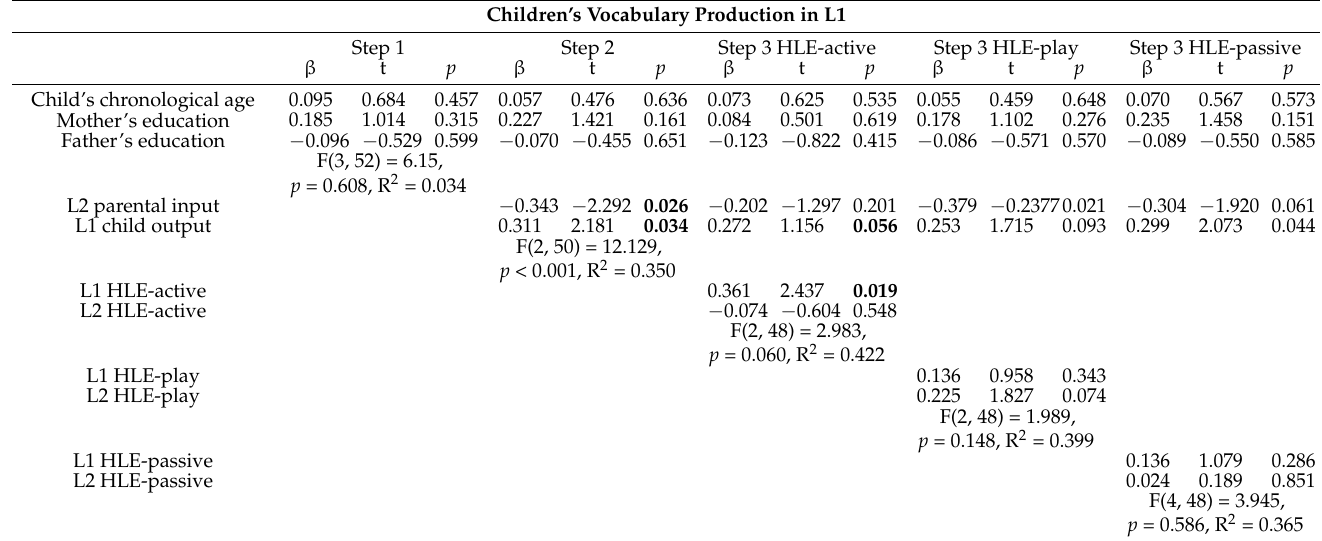
Table 4. Summary of the three stepwise regression analyses with step 3, including separate practices (active, play, and passive) for children’s vocabulary production in L1. Children’s Vocabulary Production in